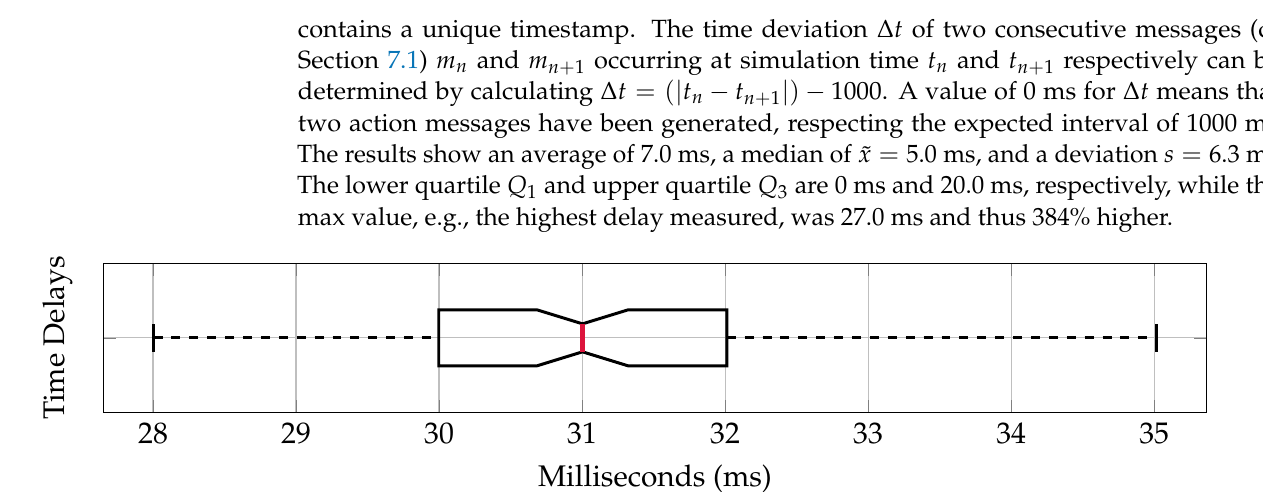
Figure 23. Time delay evaluation of the presented approach compared to a native implementation for triggering a GPIO during a benchmark with 100 iterations.